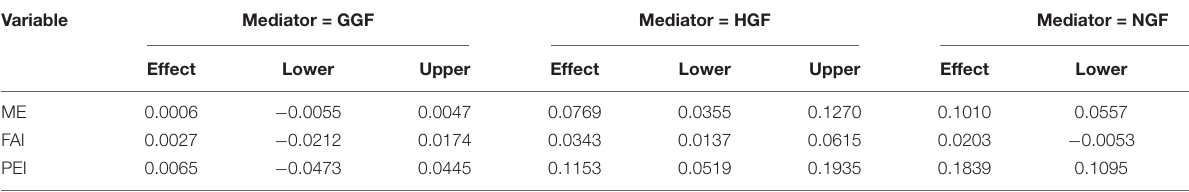
TABLE 3 | Results of specific indirect effects.